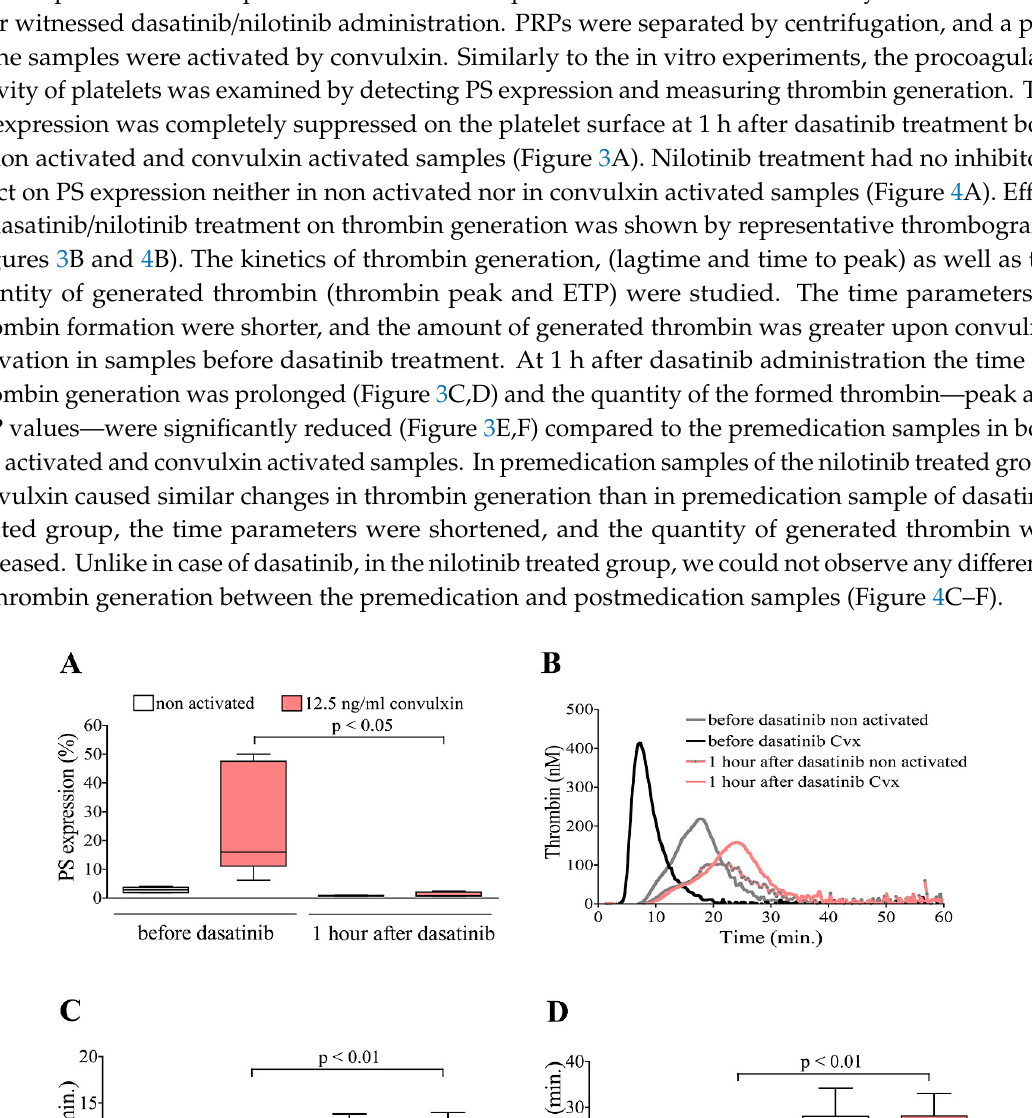
Figure 3. Treatment of chronic myeloid leukemia (CML) patients with dasatinib suppresses PS exposure and generation of thrombin in PRP. Blood was collected from dasatinib treated CML patients ( n = 5) before and at 1 h after witnessed drug administration. Platelets of patients were stimulated with 12.5 ng/mL convulxin for 15 min in PRP. PS exposure ( A ) and thrombin generation were investigated. Panel ( B ) shows representative overlay thrombin generation curves. Time